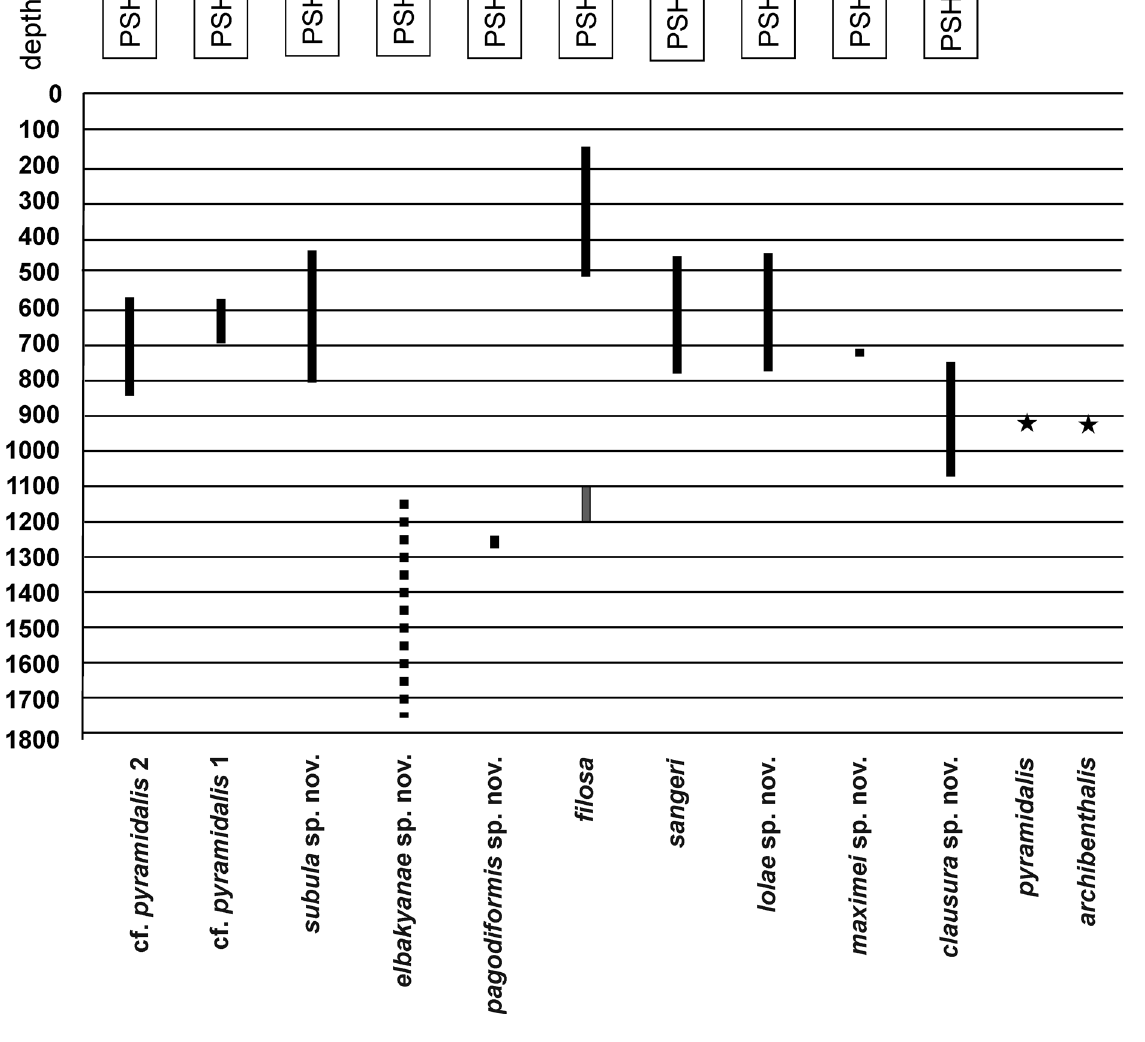
Fig. 2. Bathymetric ranges of species of Sibogasyrinx Powell, 1969 . The dashed bar for PSH 4 ( S. elbakyanae sp. nov.) marks the range of the trawl haul in which a single specimen was collected. The grey bar for PSH 6 ( S. filosa Ardovini, 2021) indicates the depths of occurrence of the type material. Stars indicate the depths of collection of the holotypes of non-sequenced